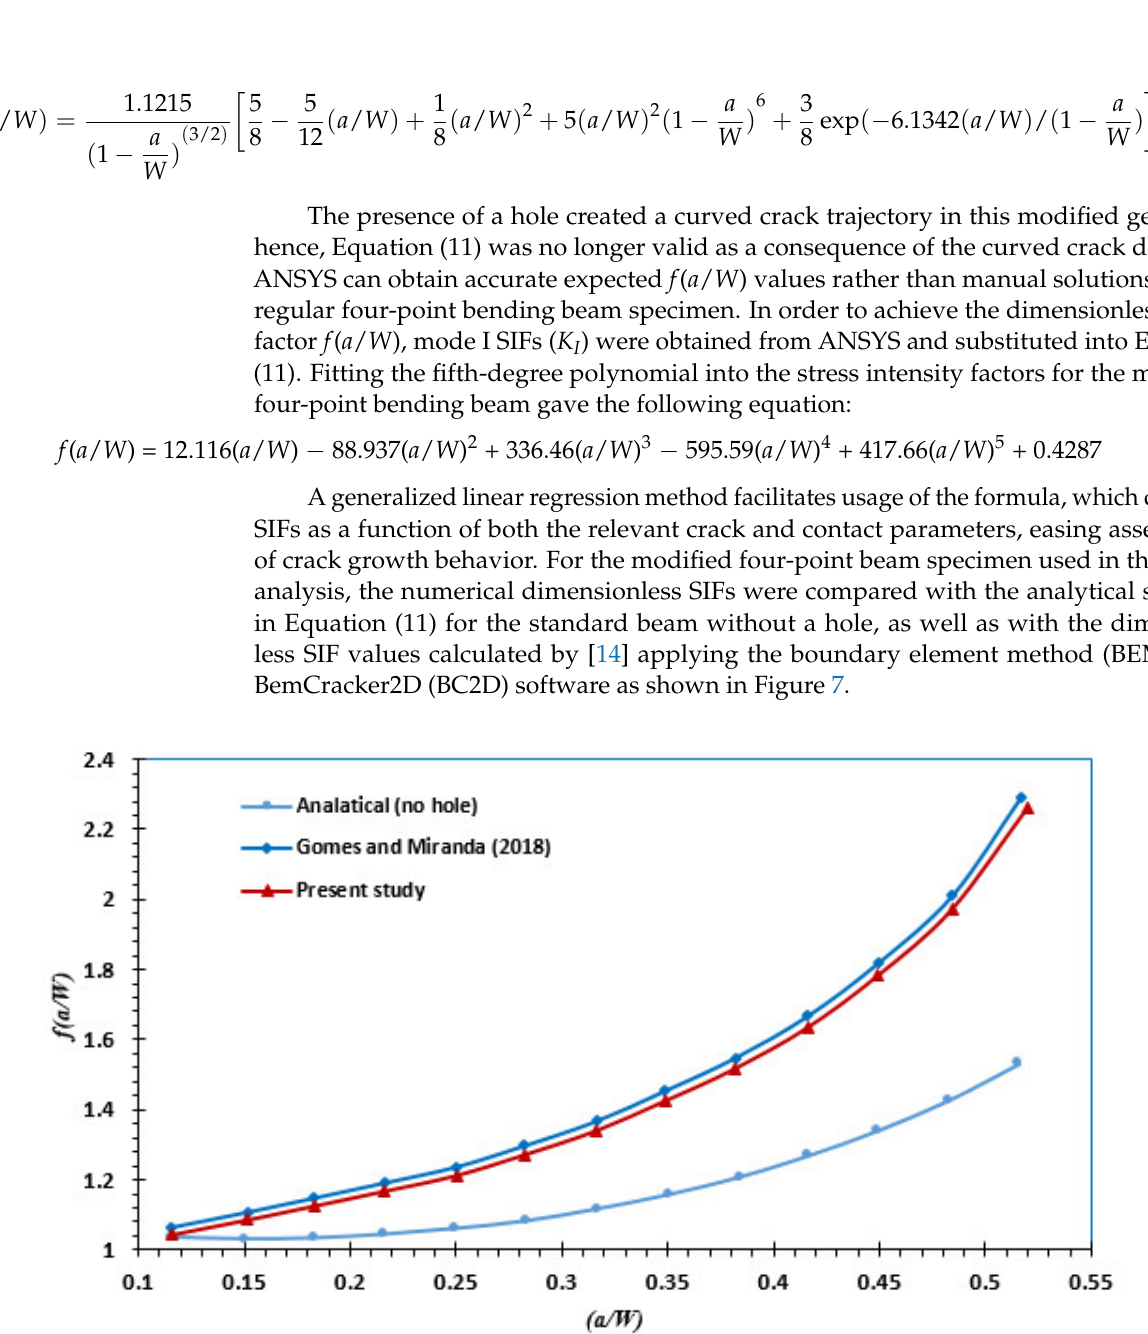
Figure 7. Dimensionless stress intensity factors for the standard and modified four-point bending beams.